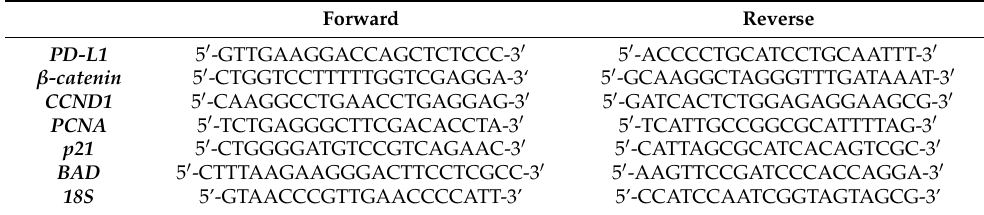
Table 1. Primer sequences for the